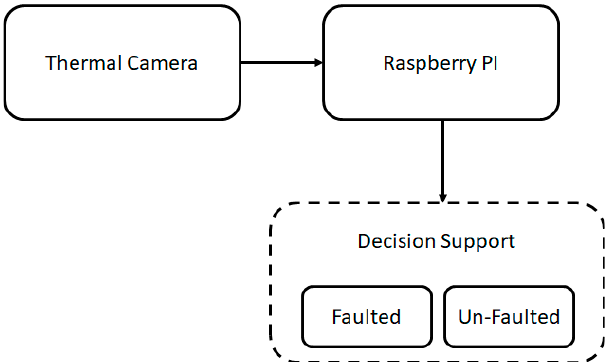
Figure 1. Block Diagram of a proposed system for the identification of electrical